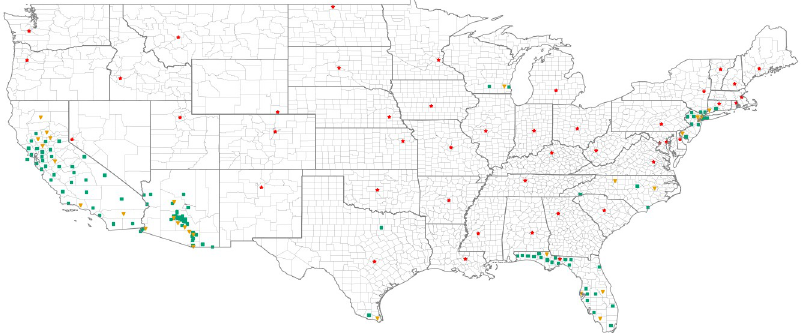
Fig 1. Map of the contiguous United States showing the locations used for training and validation (green squares), and testing (orange triangles). The locations used in the Capital Cities dataset are indicated by red stars. See Tables A and B in S7 Appendix for the names of the locations in the principal dataset. Base map obtained from the United States Census Bureau (https://www.census.gov/geographies/mapping-files/time-series/geo/carto-boundary-file.html).